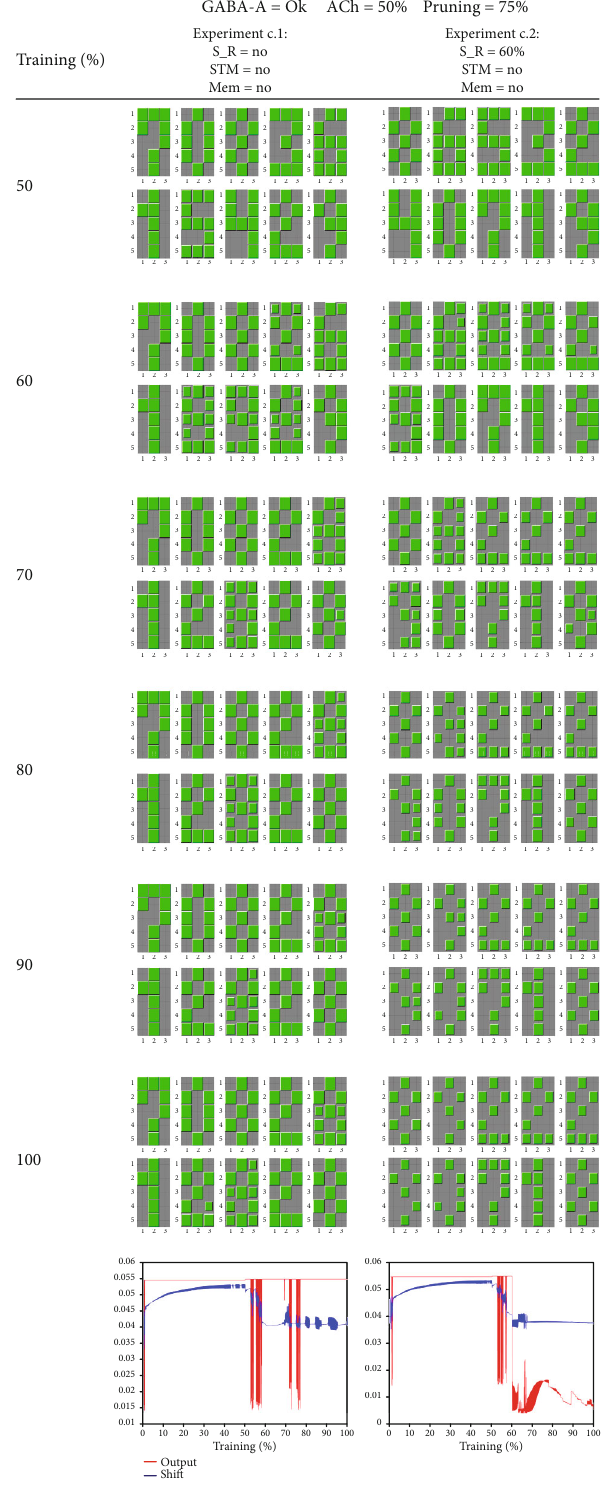
Figure 9: In these experiments, we reduce the e ff ect of ACh at 50% of epochs. Experiment c.1, in which no other modi fi cation is involved, represents a control test for comparison with subsequent experiments. In this case, the bottom graph exhibits sparse oscillations of the average output. Experiment c.2, in which stimulus reduction takes place at 60% of epochs, produced smaller but sustained oscillations that are harmful to learning patterns. Labels: S_R=sensory reduction; STM =short-term memory; Mem =memantine; ACh=acetylcholine reduction in thalamocortical